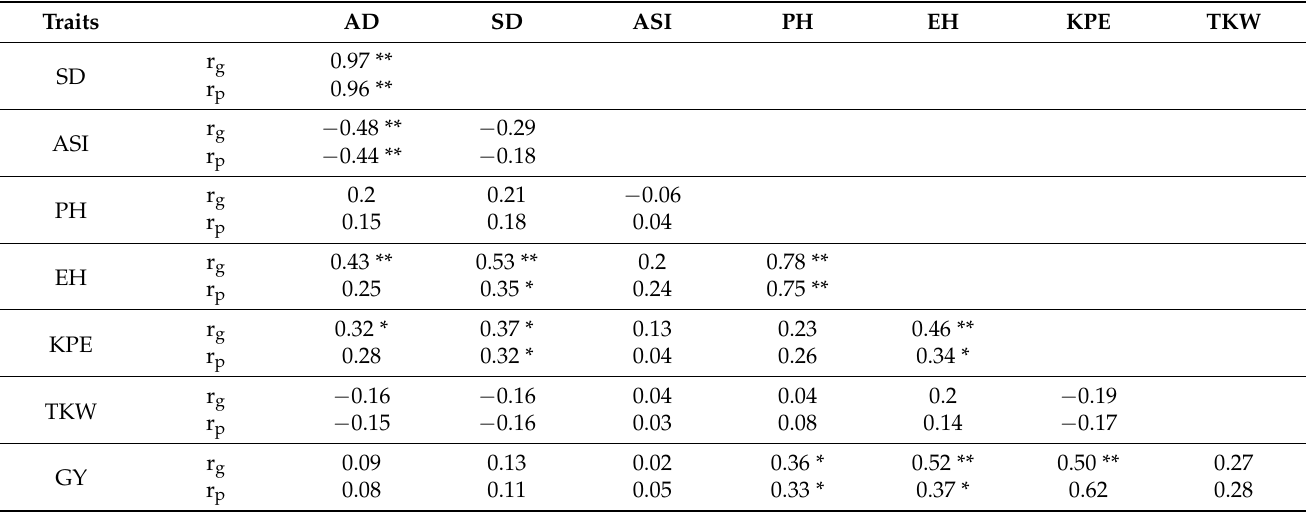
Table 3. Associations of different traits from trial evaluated at Ishwardi location.